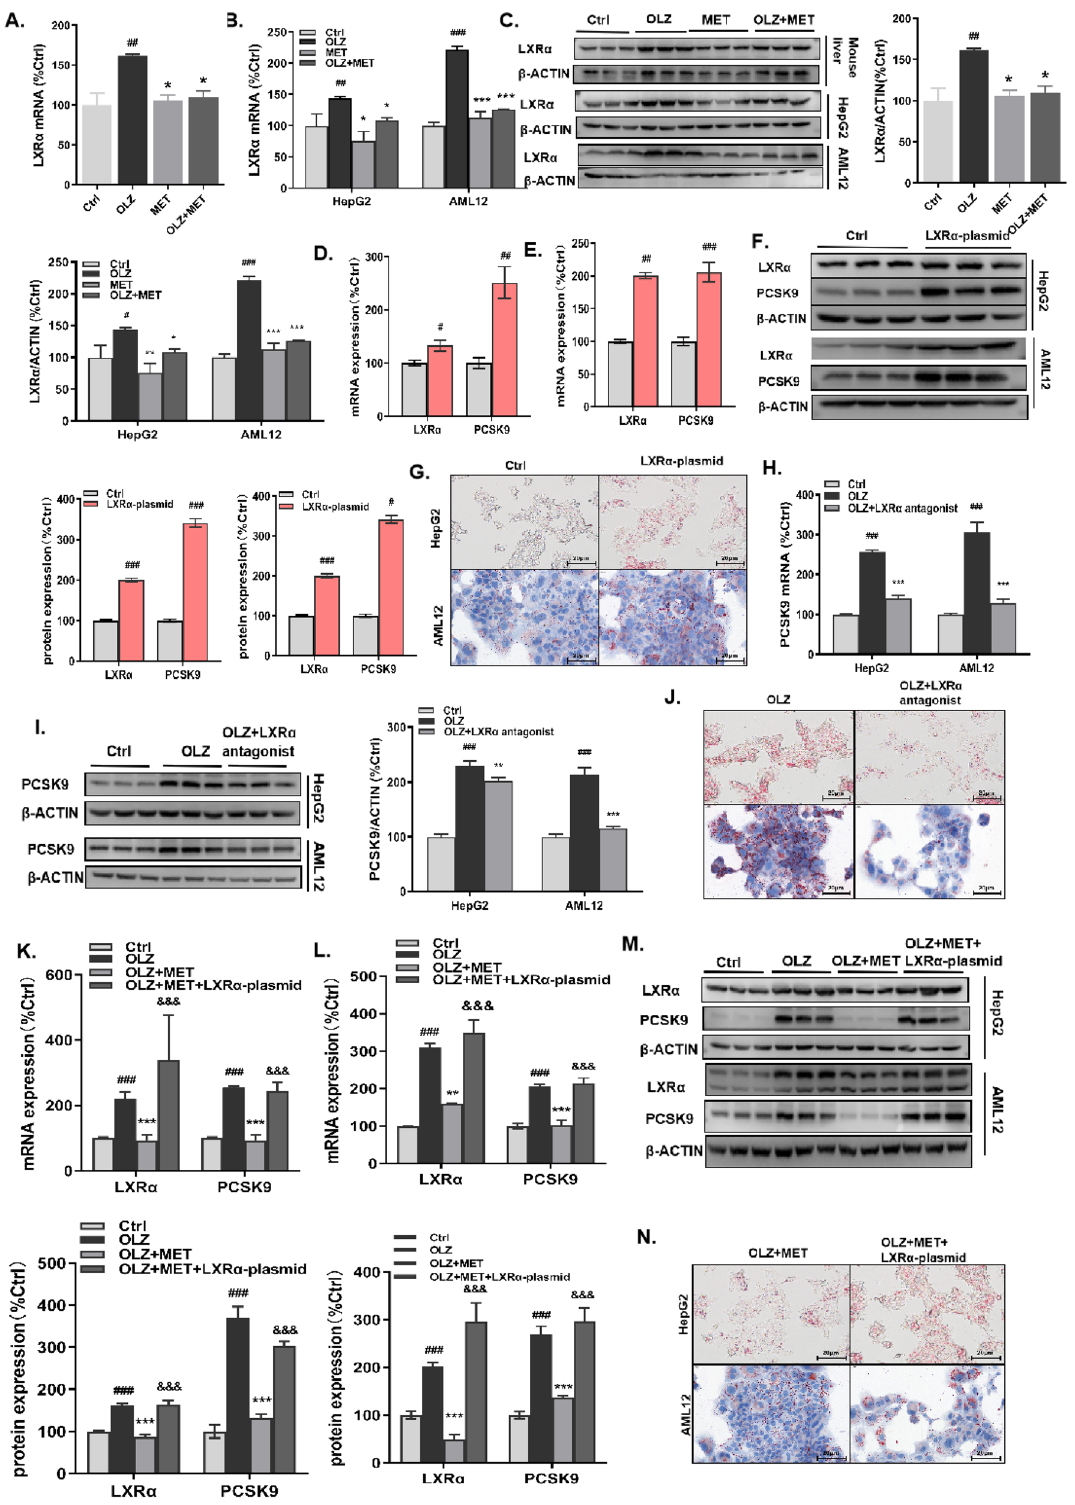
Figure 4. Metformin improves olanzapine-induced hepatic/hepatocyte steatosis via downregulation of LXRα. LXRα mRNA levels in ( A ) mouse liver tissues, ( B ) HepG2 cells and AML12 cells. LXRα protein levels in ( C ) mouse liver tissues, HepG2 cells and AML12 cells. LXRα and PCSK9 mRNA and protein levels in HepG2 cells ( D,F ) and AML12 cells ( E,F ) treated with the LXRα plasmid. ( G ) ORO staining of HepG2 cells and AML12 cells treated with LXRα plasmid. PCSK9 ( H ) mRNA and ( I ) protein levels in HepG2 cells and AML12 cells treated with an LXRα antagonist. ( J ) ORO staining of HepG2 cells and AML12 cells treated with an LXRα antagonist. PCSK9 mRNA and protein levels in ( K, M ) HepG2 cells and AML12 cells ( L, M ) treated with metformin and LXRα plasmid. ( N ) ORO staining of HepG2 cells treated with olanzapine, metformin and LXRα plasmid. Ctrl, control; OLZ, olanzapine; MET, metformin. Data represent the mean ± SEM. # p < 0.05, ## p < 0.01, ### p < 0.001 vs. control; * p < 0.05, ** p < 0.01, *** p < 0.001 vs. olanzapine; & p < 0.05, && p < 0.01, &&& p < 0.001 vs. olanzapine + metformin; one-way ANOVA plus Tukey’s post-hoc